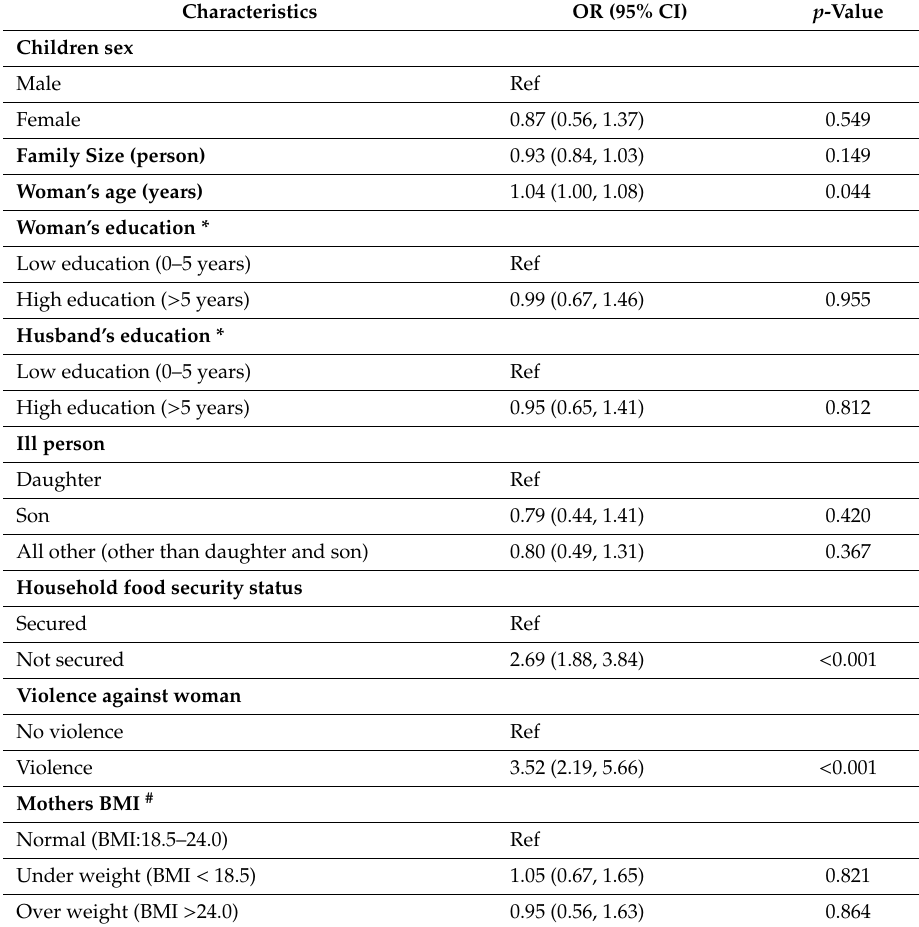
Table 2. Determinants of maternal depressive symptoms within 14 months of